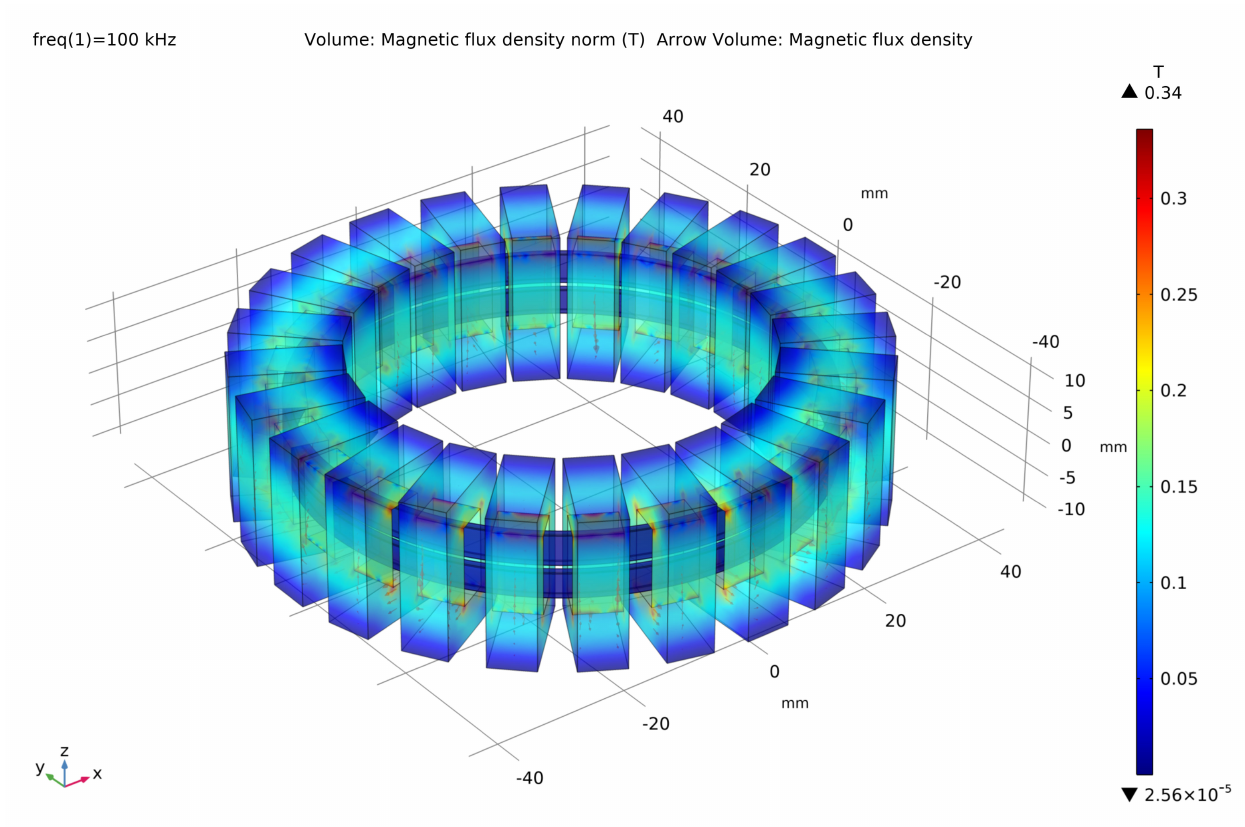
Figure 14. Magnetic flux density distribution in the ferrite cores at full-load condition and 100 kHz (air domain not